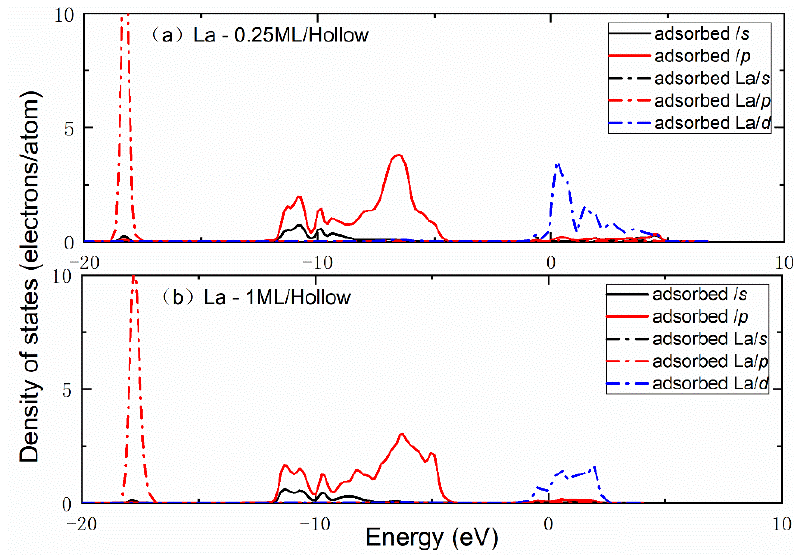
Figure 4. The PDOS of La atoms adsorbed at a hollow site and neighboring atoms of kaolinite (001) surface with a coverage of 0.25 ML ( a ) and 1.0 ML ( b ).